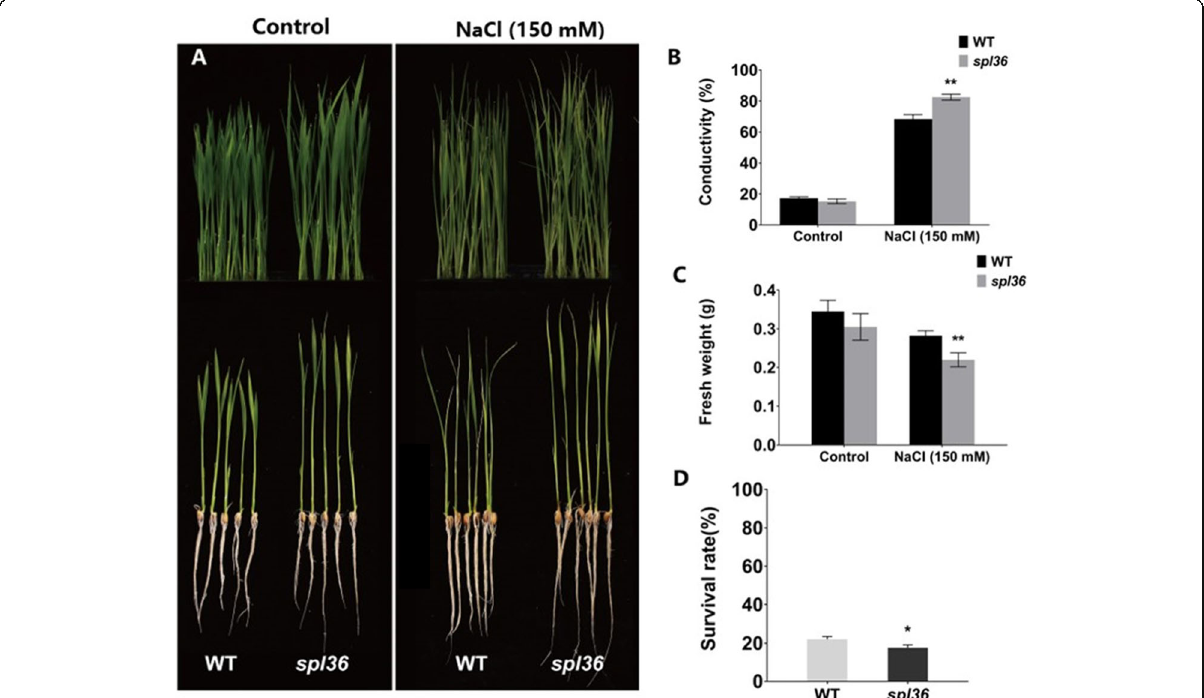
Fig. 9 Analysis of salt-stress responses in wild type and spl36 plants at the seedling stage. a Phenotypes wild-type and mutant seedlings before and after 150 mM NaCl treatment. b Conductivity of wild-type and mutant seedlings before and after 150 mM NaCl treatment. c Fresh weights of wild-type and mutant seedlings before and after 150 mM NaCl treatment. d Survival rates of wild-type and mutant seedlings after 150 mM NaCl